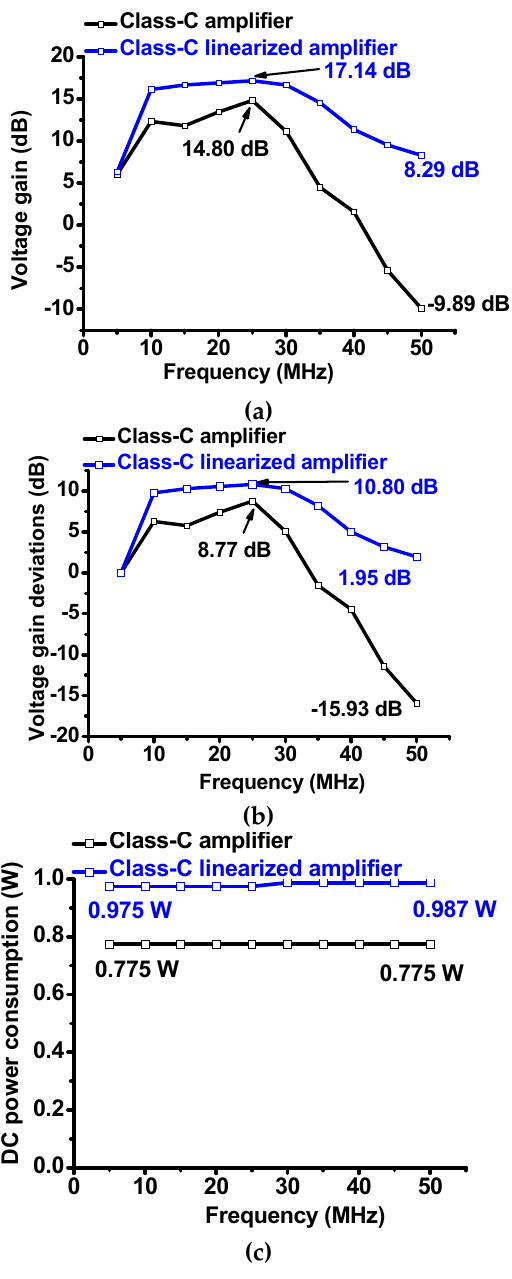
Figure 6. ( a ) Voltage gains versus frequencies of class-C amplifier and class-C linearized amplifier; ( b ) voltage gain deviations versus frequencies of class-C amplifier and class-C linearized amplifier; ( c ) DC power consumption versus frequencies of class-C amplifier and class-C linearized amplifier.